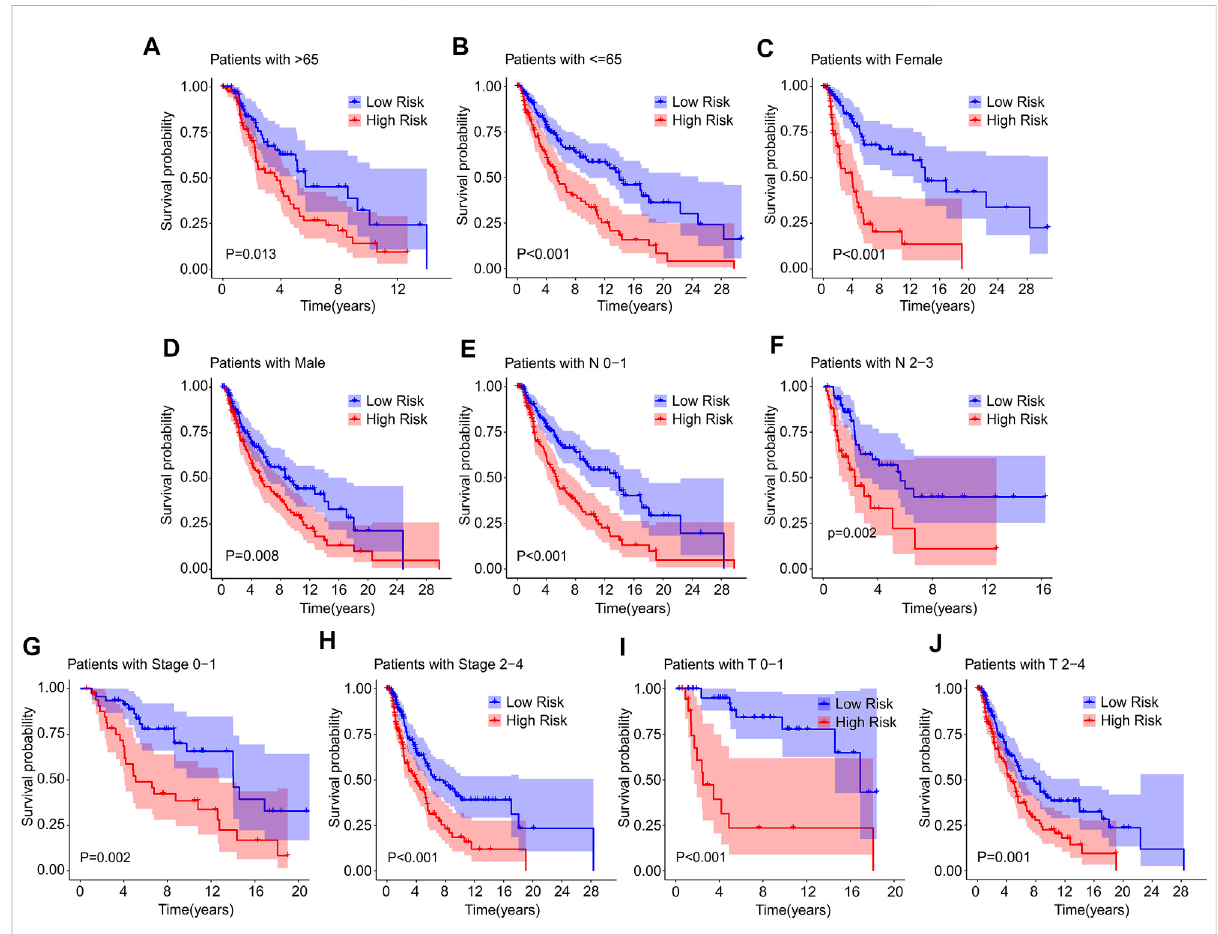
FIGURE 5 The Kaplan-Meier survival curve of patients in low- and high-risk groups strati fi ed by clinicopathological characteristics. The survival curve analysisrevealstheOSrateofpatientsinlow-andhigh-riskgroupstrati fi edby (A,B) Age( > 65vs. ≤ 65), (C,D) Gender(femalevs.male), (E,F)